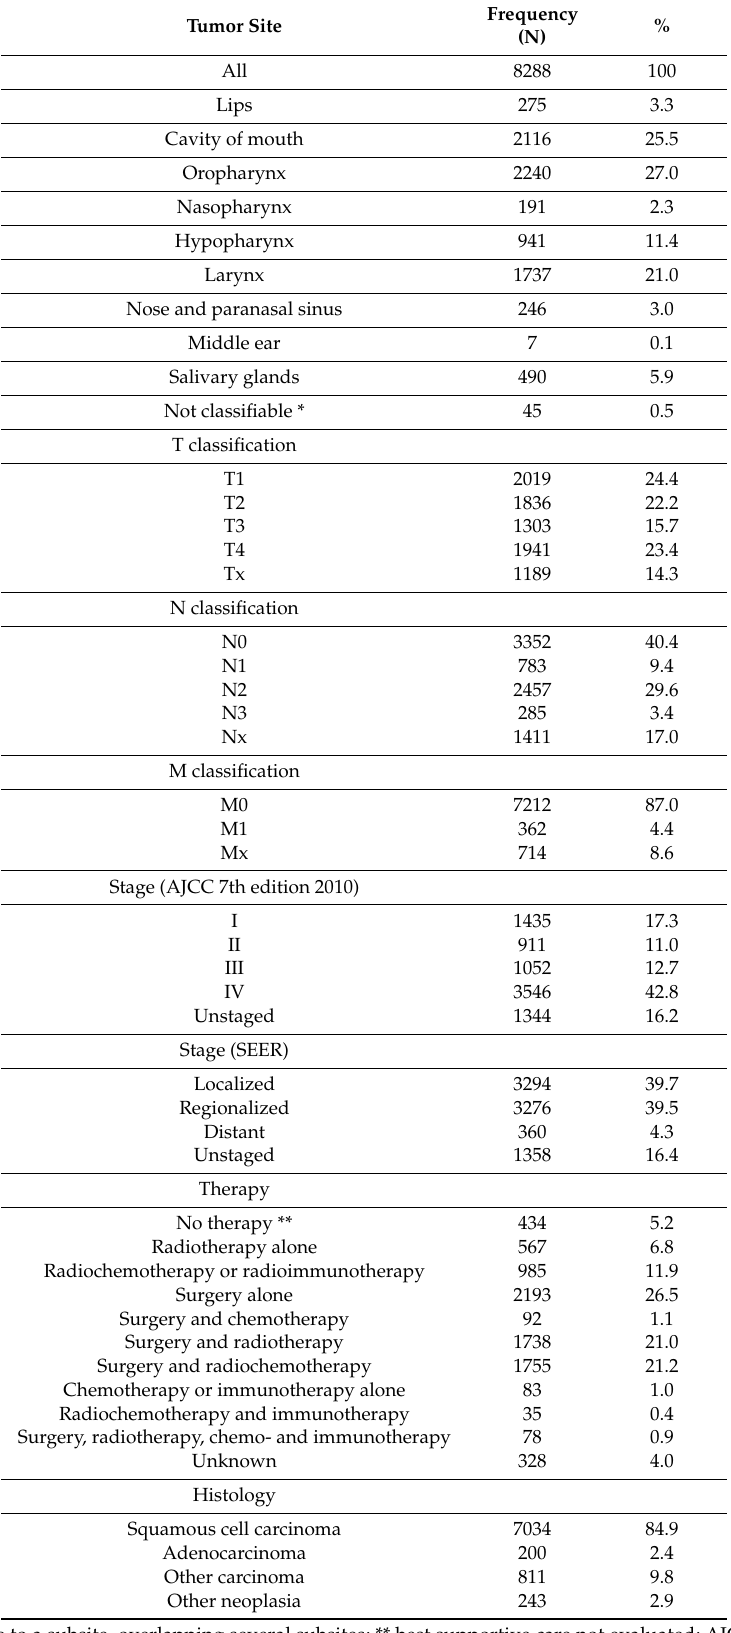
Table 1. Tumor and therapy